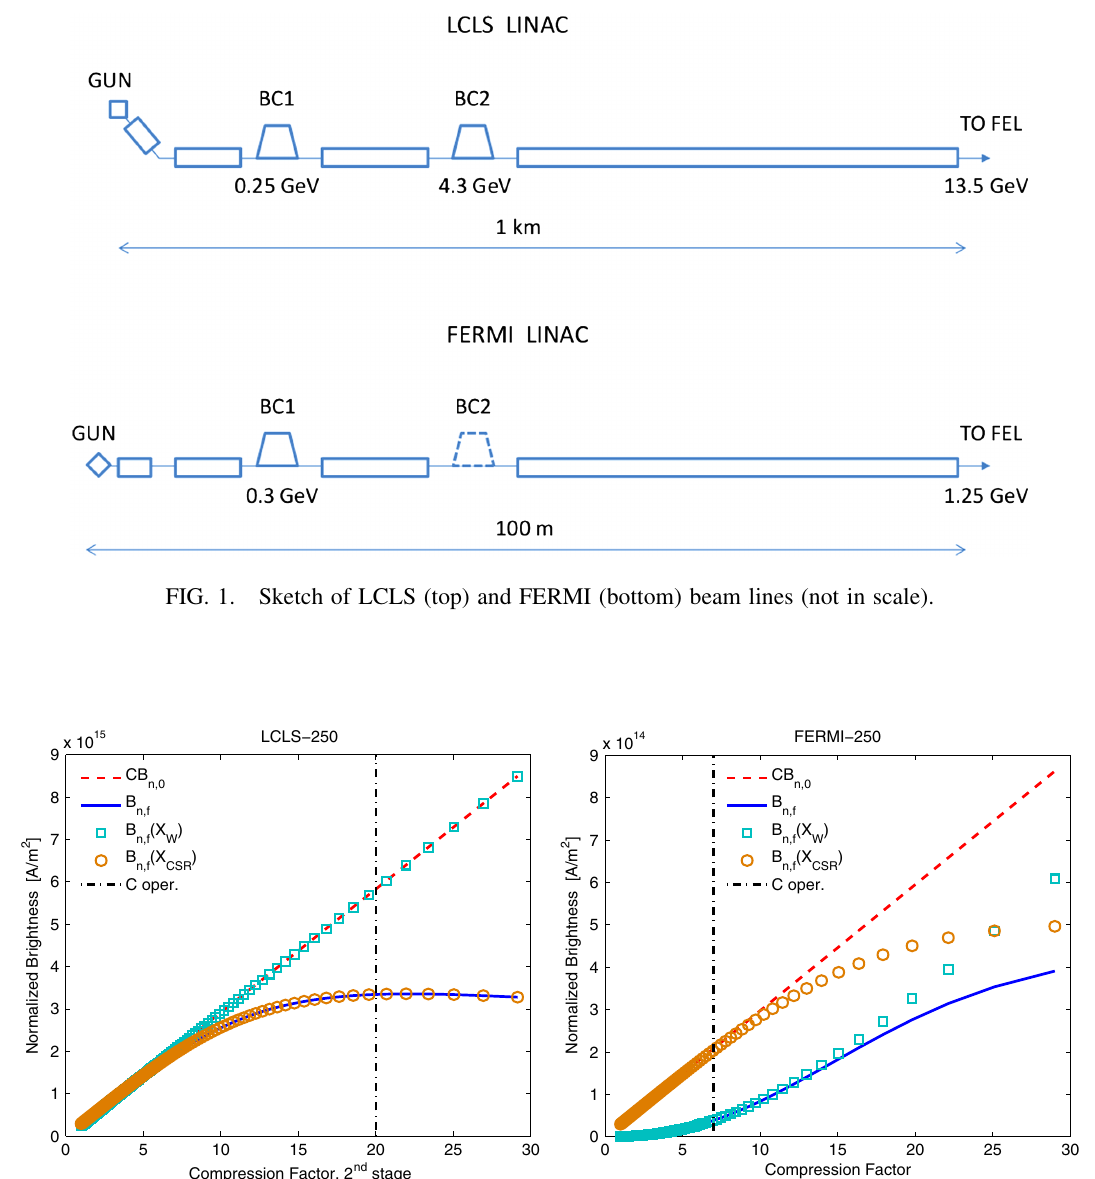
FIG. 2. Theoretical final normalized brightness in LCLS (left) and in FERMI (right) as a function of the compression factor, for 250 pC beam charge. The nominal (unperturbed) brightness is shown with a dashed line, the effective (perturbed) brightness is shown with a solid line, CSR (circles), and GTW dominated brightness (squares) is also shown. The dash-dotted line identifies the operational compression